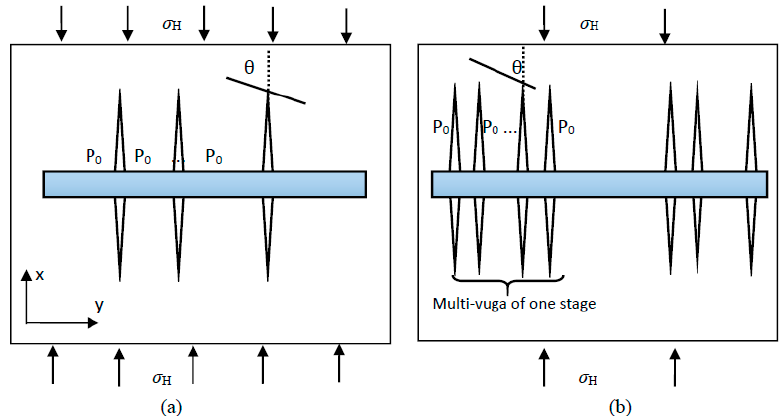
Figure 1. Illustration of network fracturing in clay formation: ( a ) multi-stage fracturing ( b ) multi-cluster fracturing. In this paper, two-dimensional planar fractures of finite height are considered. The black thin line represent the natural fracture, while the triangles denote the hydraulic